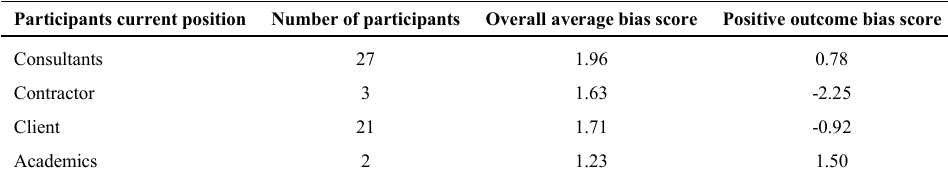
Table 2. Average bias scores based on participants’